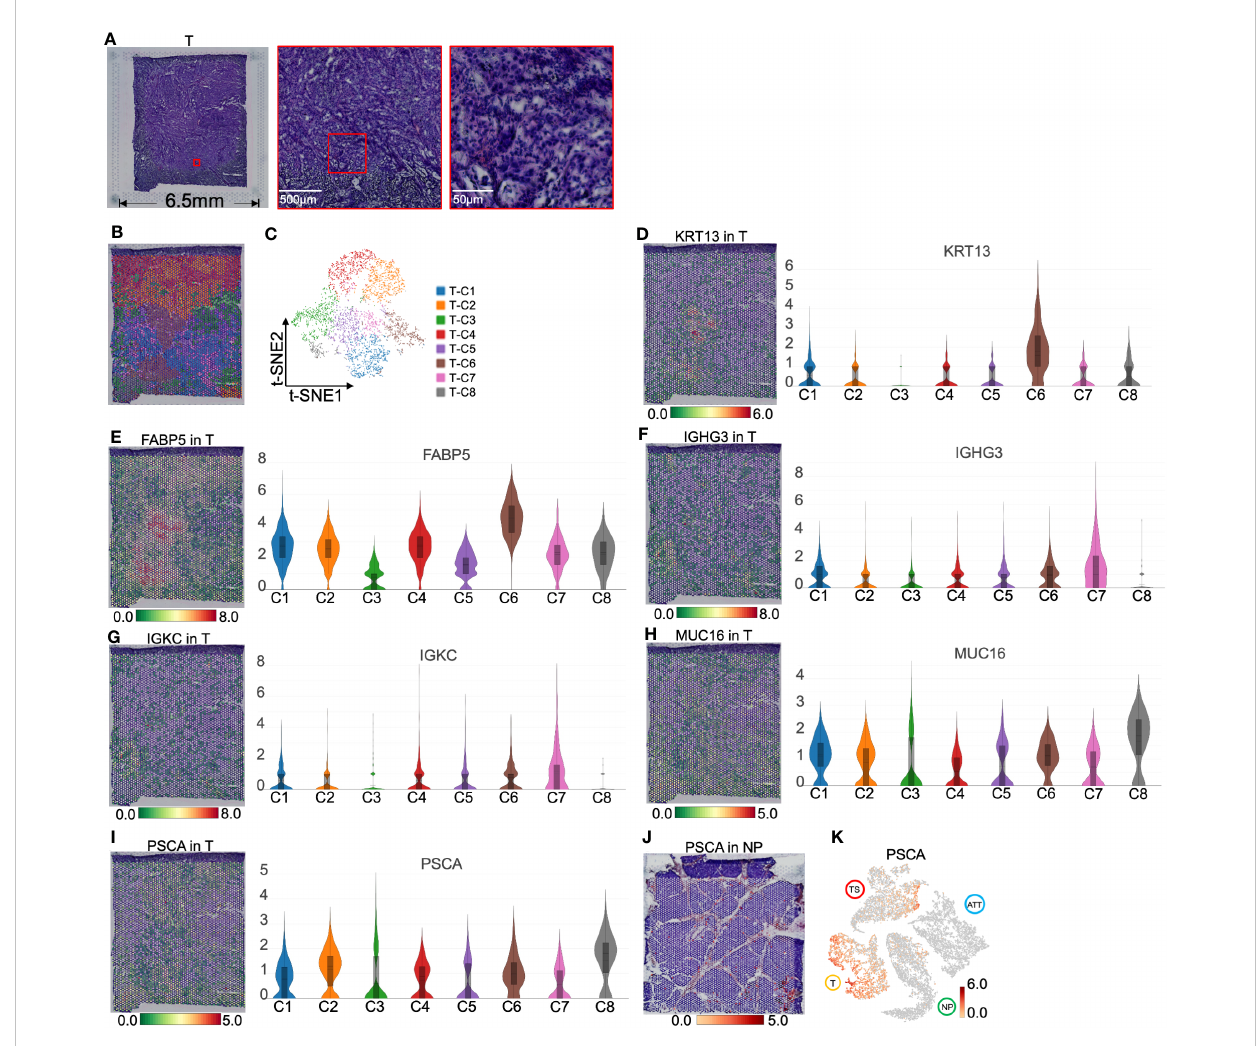
FIGURE 5 Clustering and spatial distribution of the spots from pancreatic tumor tissue (T). (A) Hematoxylin and eosin images of tumor section. (B) Spatial distribution of eight clusters in tumor tissue. (C) t-SNE plot of the eight clusters of tumor tissue. The level and distribution of KRT13 (D) , FABP5 (E) , IGHG3 (F) , and IGKC (G) , MUC16 (H) and PSCA (I) . (J) PSCA location in normal pancreas. (K) Distribution of PSCA across normal pancreas (NP), adjacent tumor tissue (ATT), tumor tissue (T), and tumor stroma (TS). The bar plots and the vertical coordinate of the violin plots indicates the log 2 FC of the gene expression value of each cluster versus the average gene